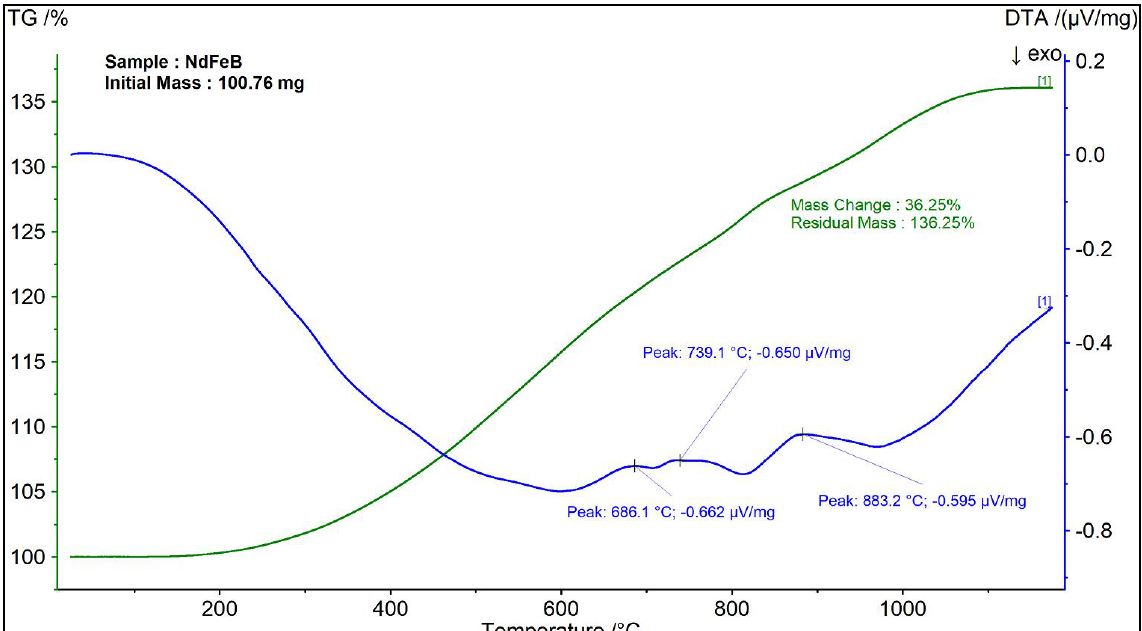
Figure 5. DTA/TGA analysis of the NdFeB magnets in air (10 K/min).